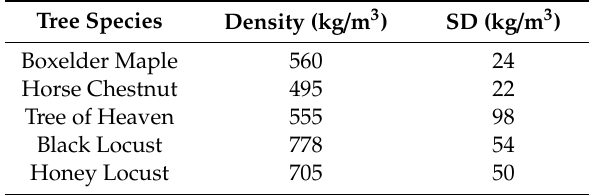
Table 1 . Material average densities and standard deviations (SD) for tested tree species. Tree Species Tree